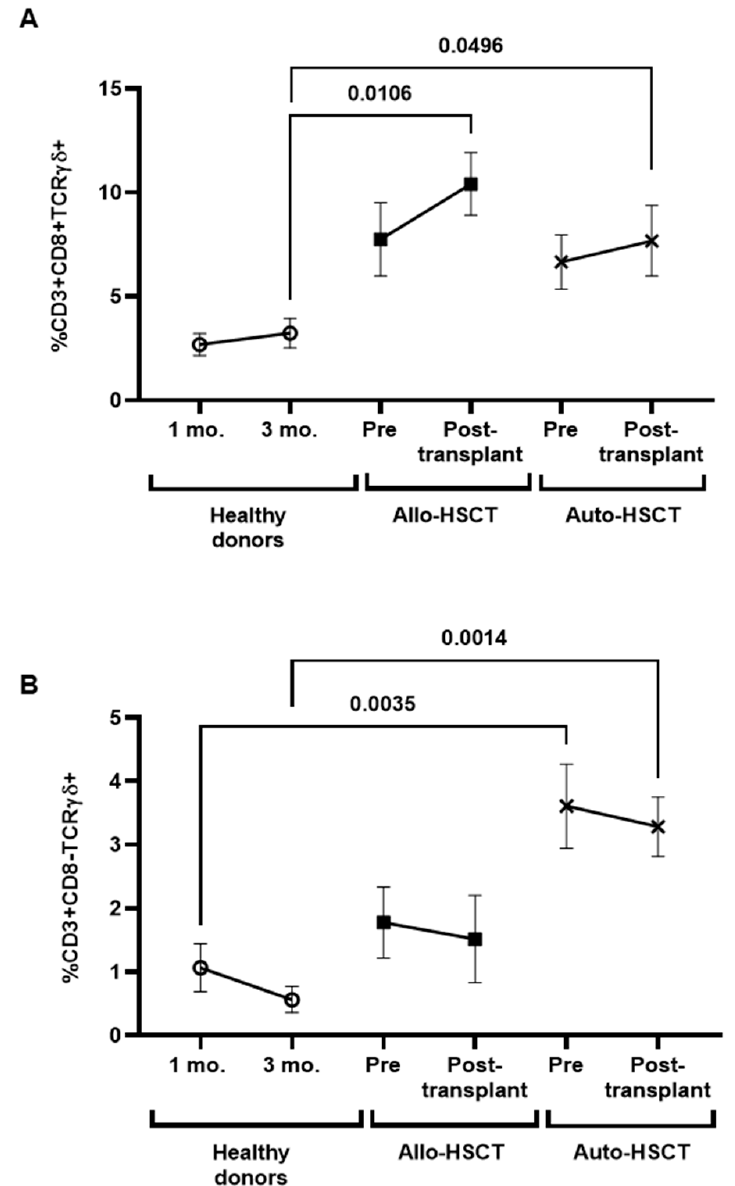
Figure 5. Characterization of TCR γδ + cells in PBMCs from individuals with OHD before and after receiving Allo- or Auto-HSCT. Levels of CD3+CD8+TCR γδ + ( A ) and CD3+CD8-TCR γδ + ( B ) cells in PBMCs from individuals with Allo- or Auto-HSCT were evaluated by flow cytometry in comparison with healthy donors. Each dot in the graphs corresponds to mean ± SEM. Different cohorts are marked with the following symbols: Healthy donors (white circles), Allo-HSCT (black squares), and Auto-HSCT (cross). Statistical significance between groups was calculated using a one-way ANOVA test, and statistical significance within groups was calculated using a t-test.